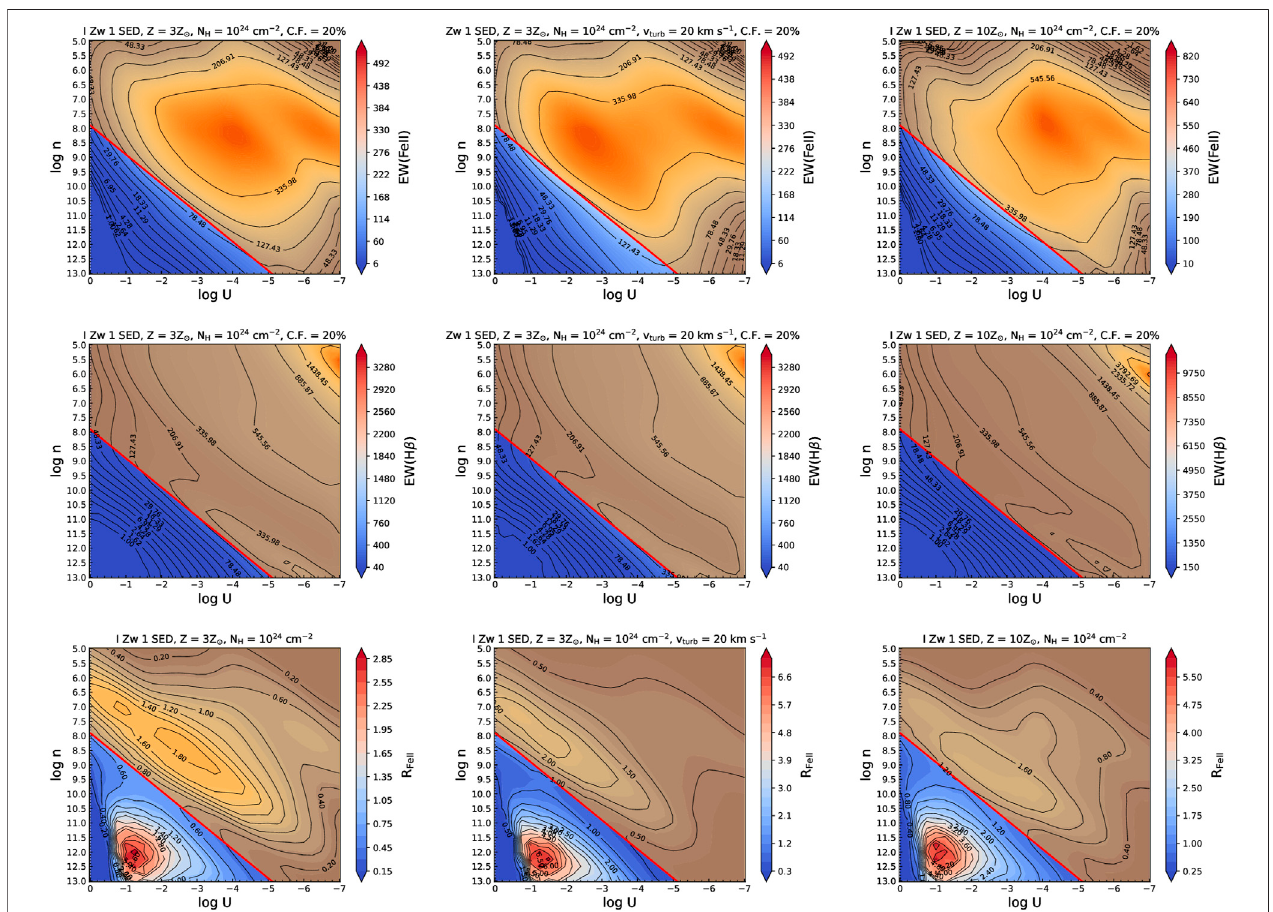
FIGURE6| Similartothelastpanel(Case4)in Figure6 .Here,wecompare thesolarcompositionmodelforthetwosources — IZw1and NGC5548.Thelocation of the respective sources is marked using a blue cross in the corresponding panels. The red plus symbol on the right panel marks the position of the value obtained for Un H using the fi ltering of EWs (see Section 4.3